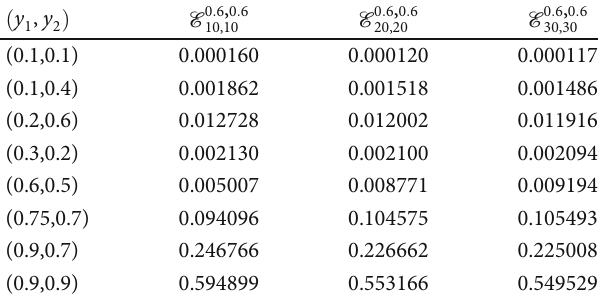
, 0 : 6 , 0 : 6 , 0 : 8 Þ ,0 : 8 ; y , y B 0 : 6 ; y , y , y : 30 , 30 , 0 : 8 ð h 30 , 30 , 0 : 8 ð h 1 2 Þ and 1 2 Þ to h ð y 1 2 Þ Table 1: Error of approximation E λ 1 , λ 2 for m 1 = m 2 = 10, 20 and m 1 , m 2